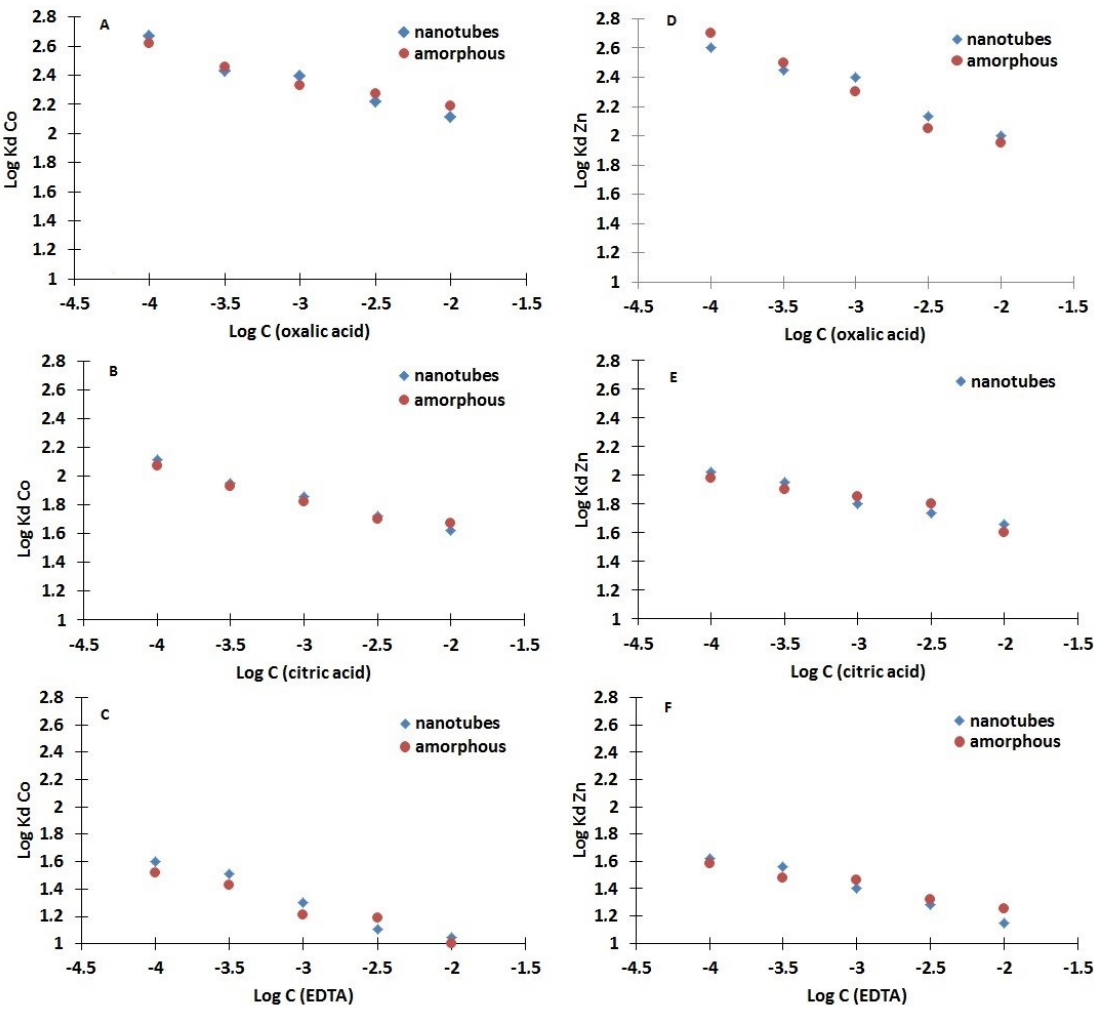
Figure 5. The dependence of 60 Co (A-C) and 65 Zn (D-F) cation distribution coefficients on the concentration of chelating agents.